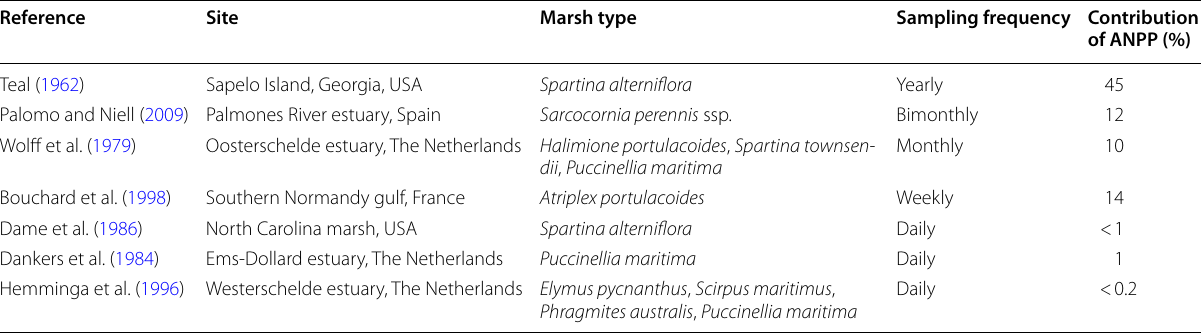
Table 1 Comparison of different sampling strategies used to collect laterally exported detritus at different study sites (ANPP aboveground net primary production) = Reference